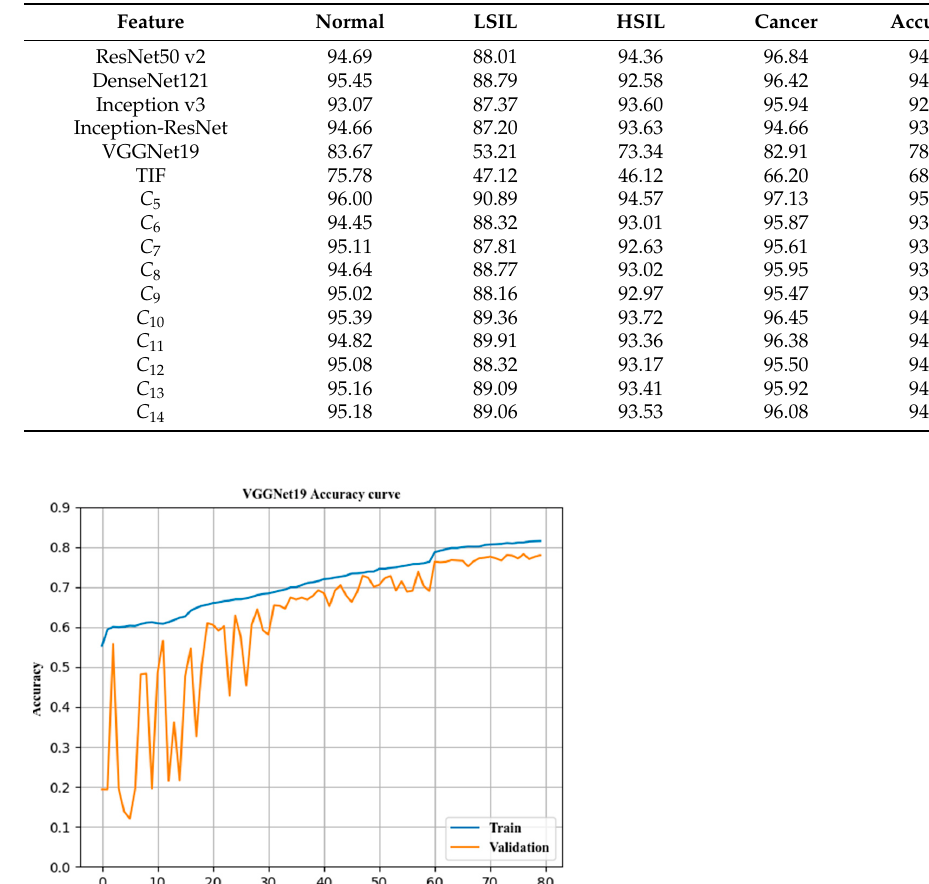
Figure 7a. Comparison of ET Weihts features Figure 7b. Comparison of Chi2 Weihts features